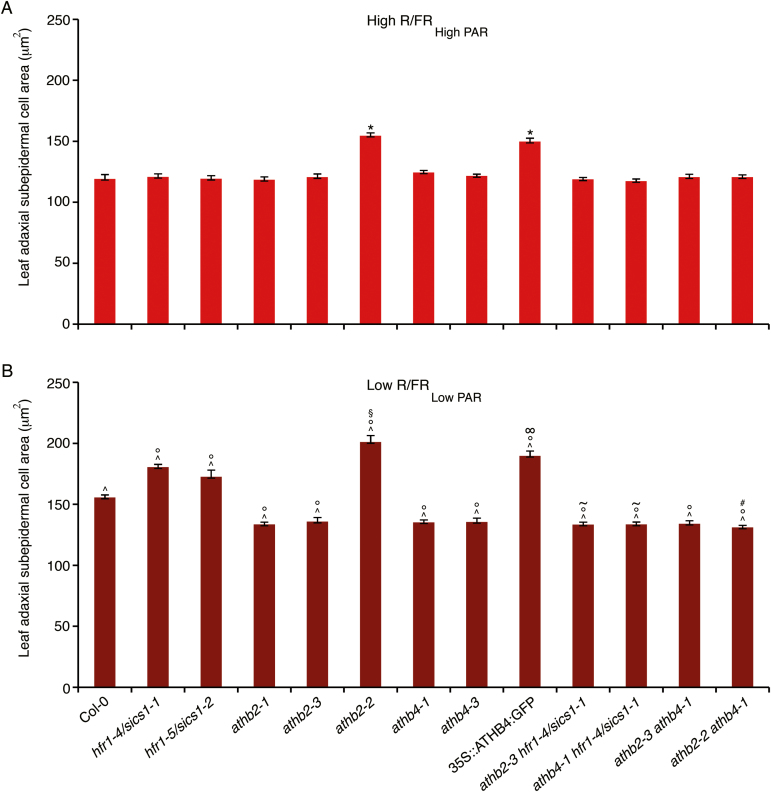
Leaf cell response to shade requires the HD-Zip II proteins ATHB2 and ATHB4. Col-0, hfr1-4/sics1-1, hfr1-5/sics1-2, athb2-1, athb2-3, athb2-2, athb4-1, athb4-3, 35S::ATHB4:GFP#13-3, athb2-3 hfr1-4/sics1-1, athb4-1 hfr1-4/sics1-1, athb2-3 athb4-1, and athb2-2 athb4-1 seedlings were grown in a light/dark cycle (16/8 h) in High R/FRHigh PAR (8 d for all the lines) (High R/FRHigh PAR), or for 4 d in high R/FR and subsequently for 5.5 d (Col-0, athb2-1, athb2-3, athb2-2, athb4-1, athb4-3, athb2-3 athb4-1, athb2-2 athb4-1) or 6.5 d (hfr1-4/sics1-1, hfr1-5/sics1-2, 35S::ATHB4:GFP#13-3, athb2-3 hfr1-4/sics1-1, athb4-1 hfr1-4/sics1-1) in Low R/FRLow PAR (Low R/FRLow PAR). The graph shows the mean area of adaxial subepidermal cells of wild-type, mutant, and transgenic leaves with an area of ~0.35 mm2 in High R/FRHigh PAR and Low R/FRLow PAR. First and second leaf area (mean ±SE), High R/FRHigh PAR: Col-0, 0.35 ± 0.004 mm2; hfr1-4/sics1-1, 0.35 ± 0.005 mm2; hfr1-5/sics1-2, 0.34 ± 0.008 mm2; athb2-1, 0.35 ± 0.003 mm2; athb2-3, 0.35 ± 0.005 mm2; athb2-2, 0.35 ± 0.003 mm2; athb4-1, 0.35 ± 0.006 mm2; athb4-3, 0.34 ± 0.003 mm2; 35S::ATHB4:GFP#13-3, 0.33 ± 0.003 mm2; athb2-3 hfr1-4/sics1-1, 0.35 ± 0.005 mm2; athb4-1 hfr1-4/sics1-1, 0.35 ± 0.004 mm2; athb2-3 athb4-1, 0.34 ± 0.003 mm2; athb2-2 athb4-1, 0.33 ± 0.006 mm2. First and second leaf area (mean ±SE), Low R/FRLow PAR: Col-0, 0.35 ± 0.003 mm2; hfr1-4/sics1-1, 0.34 ± 0.005 mm2; hfr1-5/sics1-2, 0.34 ± 0.009 mm2; athb2-1, 0.34 ± 0.004 mm2; athb2-3, 0.36 ± 0.008 mm2; athb2-2, 0.34 ± 0.007 mm2; athb4-1, 0.35 ± 0.007 mm2; athb4-3, 0.35 ± 0.005 mm2; 35S::ATHB4:GFP#13-3, 0.36 ± 0.003 mm2; athb2-3 hfr1-4/sics1-1, 0.34 ± 0.005 mm2; athb4-1 hfr1-4/sics1-1, 0.35 ± 0.004 mm2; athb2-3 athb4-1, 0.35 ± 0.004 mm2; athb2-2 athb4-1, 0.35 ± 0.008 mm2. *P<0.0001 athb2-2, 35S::ATHB4:GFP#13-3 High R/FRHigh PAR versus Col-0 High R/FRHigh PAR; ^P<0.0001 Col-0, hfr1-4/sics1-1, hfr1-5/sics1-2, athb2-1, athb2-3, athb2-2, athb4-1, athb4-3, 35S::ATHB4:GFP#13-3, athb2-3 hfr1-4/sics1-1, athb4-1 hfr1-4/sics1-1, athb2-3 athb4-1, athb2-2 athb4-1 Low R/FRLow PAR versus Col-0 High R/FRHigh PAR; °P<0.0001 hfr1-4/sics1-1, hfr1-5/sics1-2, athb2-1, athb2-3, athb2-2, athb4-1, athb4-3, 35S::ATHB4:GFP#13-3, athb2-3 hfr1-4/sics1-1, athb4-1 hfr1-4/sics1-1, athb2-3 athb4-1, athb2-2 athb4-1 Low R/FRLow PAR versus Col-0 Low R/FRLow PAR; §P<0.0001 athb2-2 Low R/FRLow PAR versus athb2-2 High R/FRHigh PAR; ∞P<0.0001 35S::ATHB4:GFP#13-3 Low R/FRLow PAR versus 35S::ATHB4:GFP#13-3 High R/FR High PAR; ~P<0.0001 athb2-3 hfr1-4/sics1-1, athb4-1 hfr1-4/sics1-1 Low R/FRLow PAR versus hfr1-4/sics1-1 Low R/FRLow PAR; # P<0.0001 athb2-2 athb4-1 Low R/FRLow PAR versus athb2-2 Low R/FRLow PAR.